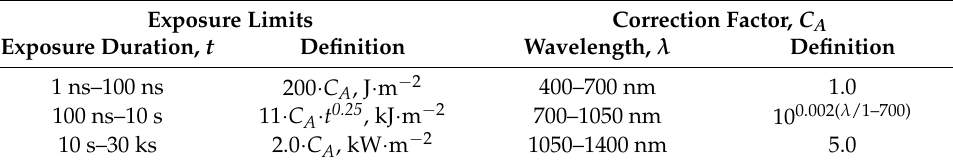
Figure 8. Schematic illustration of light-responsive drug delivery systems including smart delivery systems employing photosensitizers for photodynamic therapy (PDT), delivery systems employ- ing heat mediators such as gold nanoparticles for photothermal therapy (PTT), and directly light- triggered release delivery systems. Reproduced with permission from [151]. Copyright Informa UK Limited. Table 2. Laser radiation exposure limits for the skin